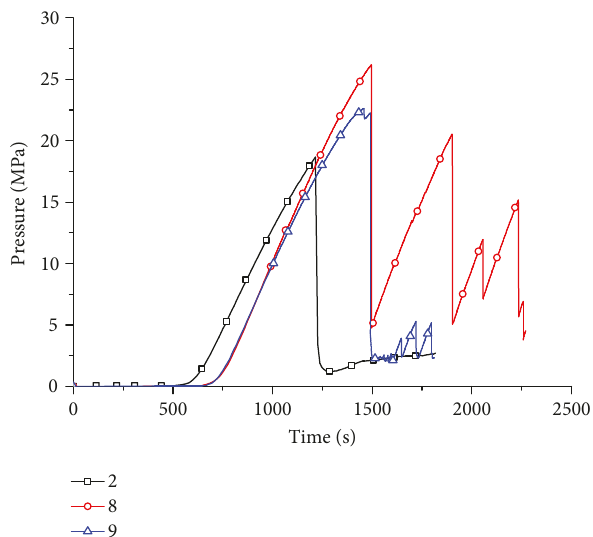
Figure 11: Pressure curves in the core fracturing process.